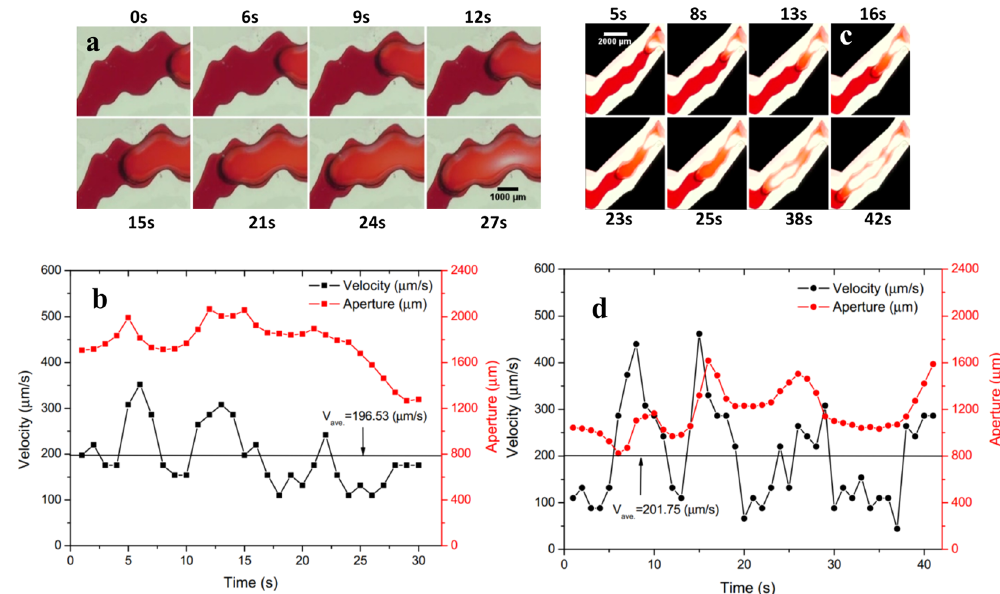
Figure 2. Time-lapse images showing interfacial dynamics in typical aperture geometries: ( a ) In-phase #1 and ( c ) In-phase #2. Temporal changes in the interfacial velocity and corresponding aperture width for In-phase roughness #1 ( b ) and In-phase roughness #2 ( d